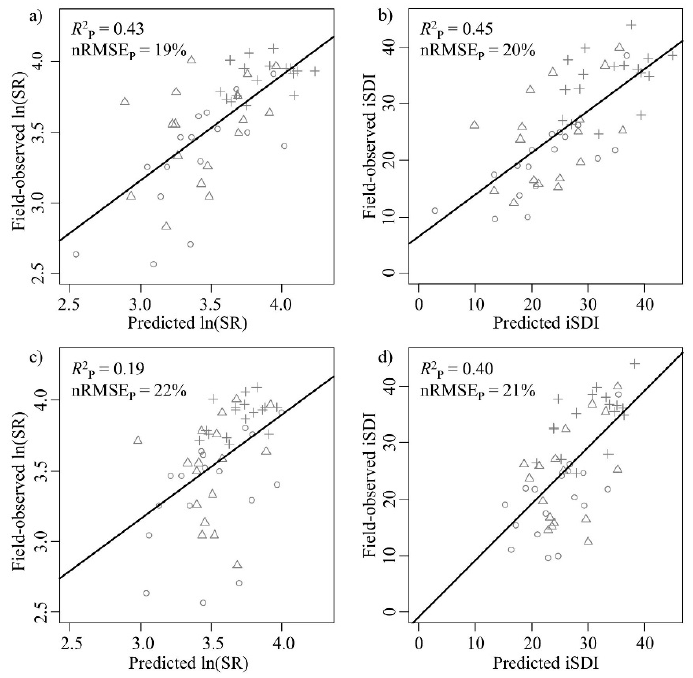
Figure 4. Correlations between field-observed and predicted ( left column ) species richness (ln(SR)) and ( right column ) inverse Simpson’s diversity (iSDI) for the validation subset ( n = 51). ( a , b ) show the field-observed versus the predicted correlations for the PLSR model based on the full set of wavebands (Model 1) ( n = 245); ( c , d ) show the field-observed versus the predicted correlations for the model based on a subset of wavebands (Model 2) ( n = 25 (for ln(SR)) or 35 (for iSDI)). The normalized prediction error (nRMSE P , %) indicates the quality of the model in predicting the observed species diversity measure, and the squared correlation ( R 2P ) indicates the fit between the predicted and observed diversity value. The age-class of the grassland plots is also displayed (key: ○ young, ∆ intermediate, and + old). Black lines indicate the relationship between the predicted and the measured values.